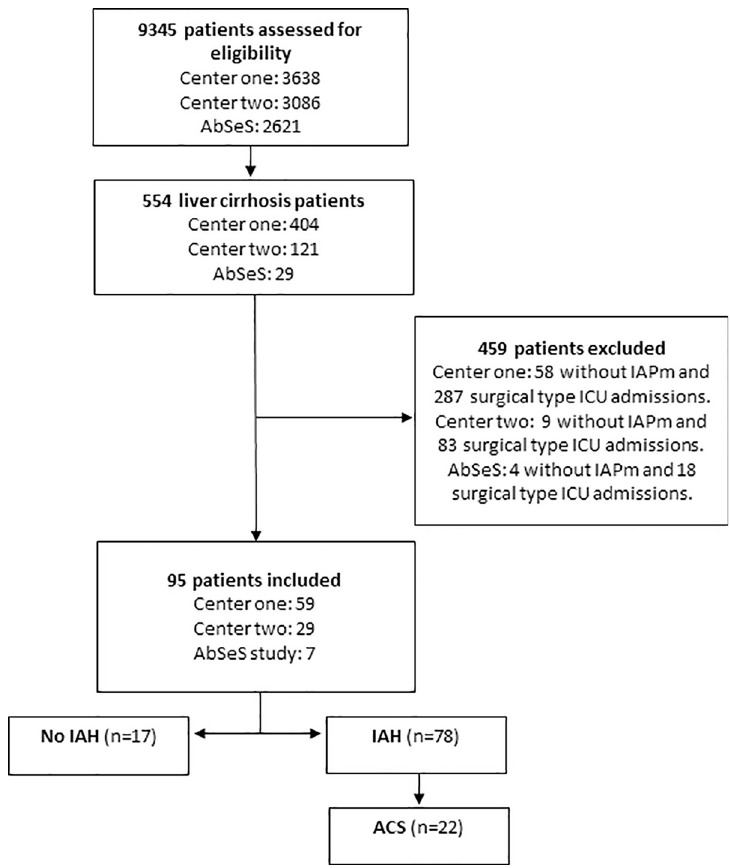
Fig 1. Patient flowchart. Patients with liver cirrhosis were considered eligible and were excluded if surgical type ICU admission or absence of IAPm. Abbreviations: AbSeS–Abdominal Sepsis Study: Epidemiology of Etiology and Outcome; ACS–Abdominal Compartment Syndrome; ICU–Intensive Care Unit; IAH–Intra-abdominal Hypertension; IAPm–Intra-Abdominal Pressure measure. and PaO2/FiO2 (p = 0.1) nearly reached significant association (Table 2). Multivariable analy- sis (excluding GCS due to preference for WH encephalopathy score in the cirrhotic patient) revealed that alcoholic cirrhosis (p = 0.01), higher WH scores (p = 0.01), and higher PaO2/ FiO2 ratio (p = 0.02) were independently associated with the presence of IAH (S1 Table). Abdominal compartment syndrome was significantly associated with higher MELD and MELD-Na scores (respectively, p = 0.03 and p = 0.04), and precipitant event (p = 0.03) com- pared to other patients with simple IAH. White blood cell count (p = 0.08) nearly reached sig- nificant association with ACS (Table 2). Multivariate analysis (n = 71), including the aforementioned variables, showed that the precipitant event “infection” (p = 0.048) was the only independent risk factor for ACS. In-ICU mortality rate was 46.3% (n = 44), and overall, 28-day mortality was 52.6% (n = 50). Non-surviving patients had significantly higher maximum and mean IAP (p = 0.02 and p = 0.04, respectively) (Table 1) and patients with ACS had significantly higher 28-day mortal- ity when compared to those with lower IAH grades I–II (77% versus 46%, respectively, p = 0.02) (Table 2). IAH grade distribution and respective mortality rates for either maximum or mean IAP values are separately shown in Figs 2 and 3.